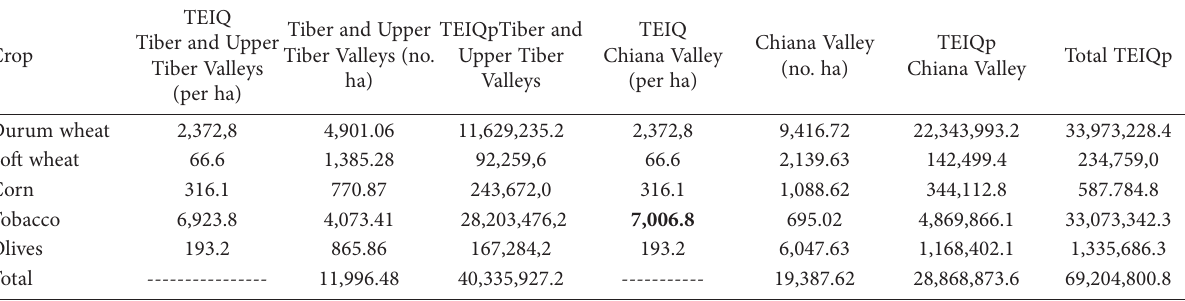
Table 3. Calculation of total TEIQp